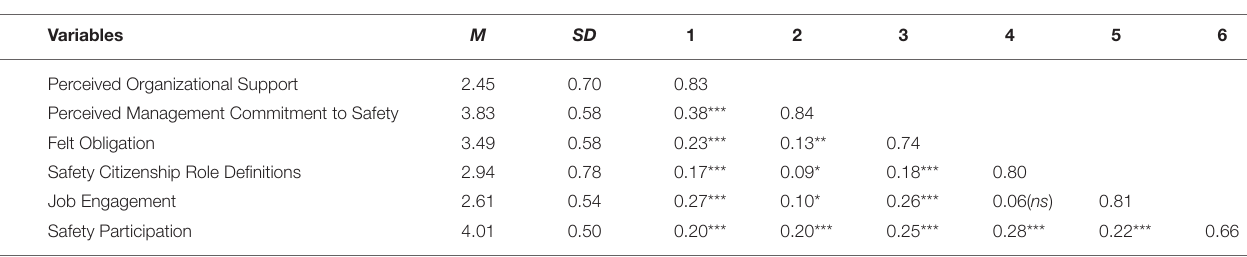
TABLE 2 | Descriptive statistics and inter-correlations among the variables.